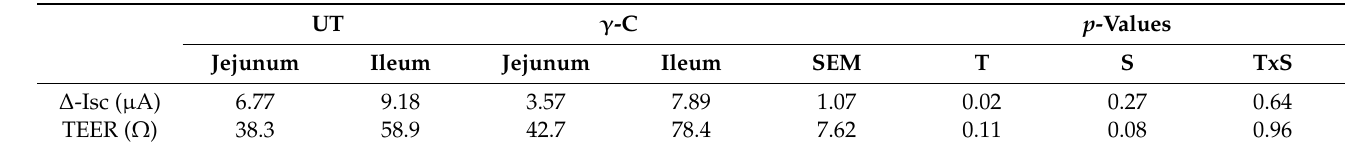
Table 2. D-glucose-induced ∆ Isc ( µ A) and transepithelial resistance (TEER) were measured on pig jejunum and ileum incubated for 30 min with 1 mg/mL ( v / v , γ -C/culture medium) compared with the untreated group (UT). Data are expressed as means with their standard errors ( n = 6 independent experiments). Abbreviations: T = Treatment; S = Segment.